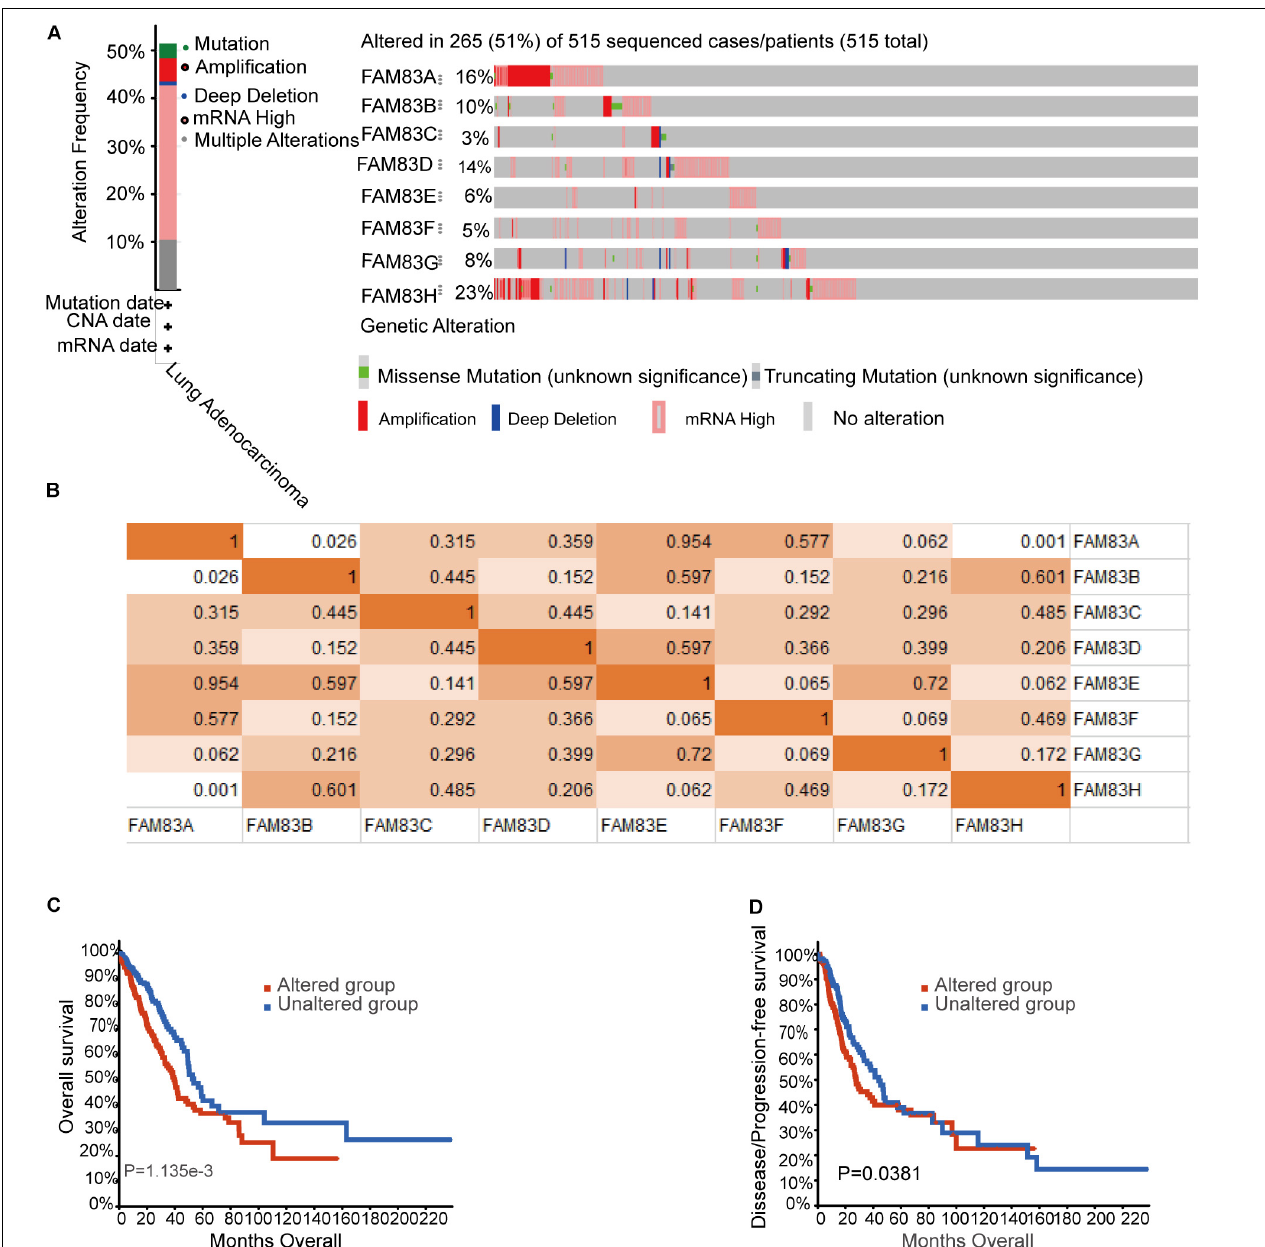
FIGURE 6 | Genetic mutations in FAM83 family and their association with OS and DFS of NSCLC patients (cBioPortal). (A) Summary of alterations in different expressed FAM83 family in LUAD. (B) Correlations of different FAM83 family members with each other in LUAD. (C) Genetic alterations in FAM83 family were related to shorter OS and (D) DFS of LUAD